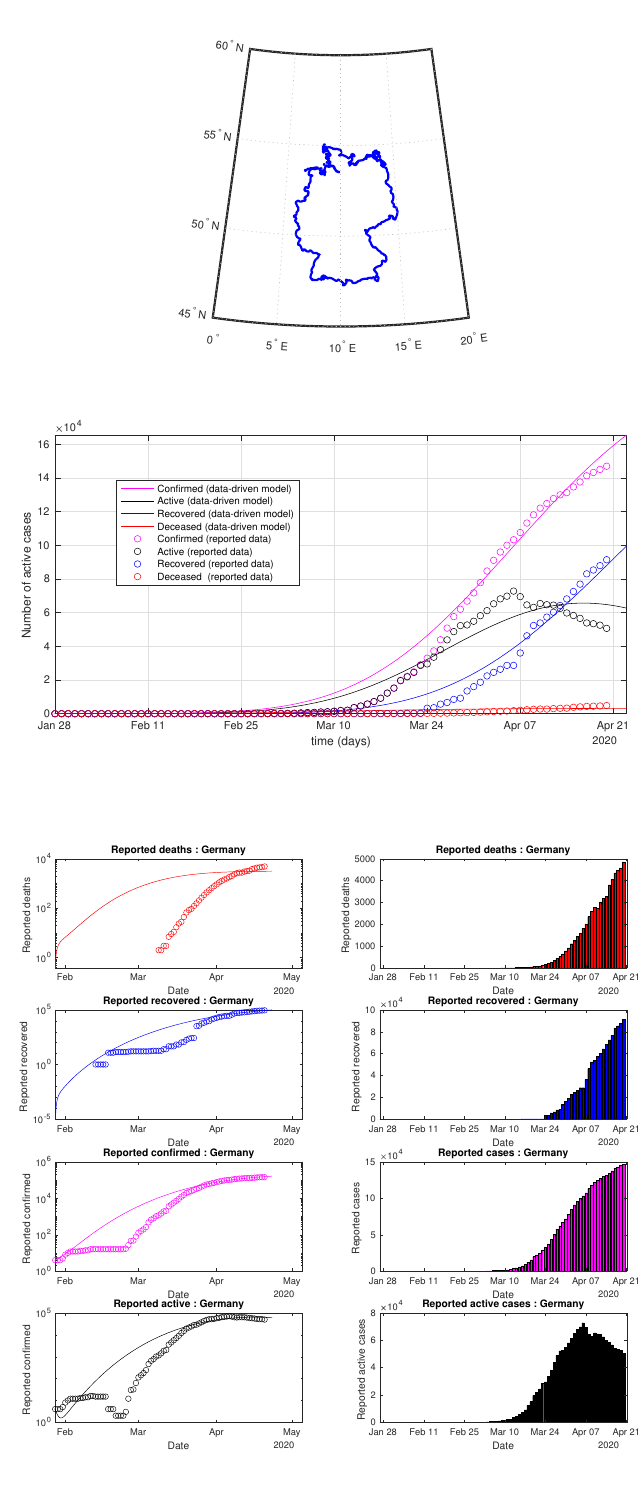
Figure 41. Germany: data of active, recovered, deceased (in circle or bar) vs. model of active, recovered, deceased over time. Tracking the number of active cases. Predictive analytics for the next couple